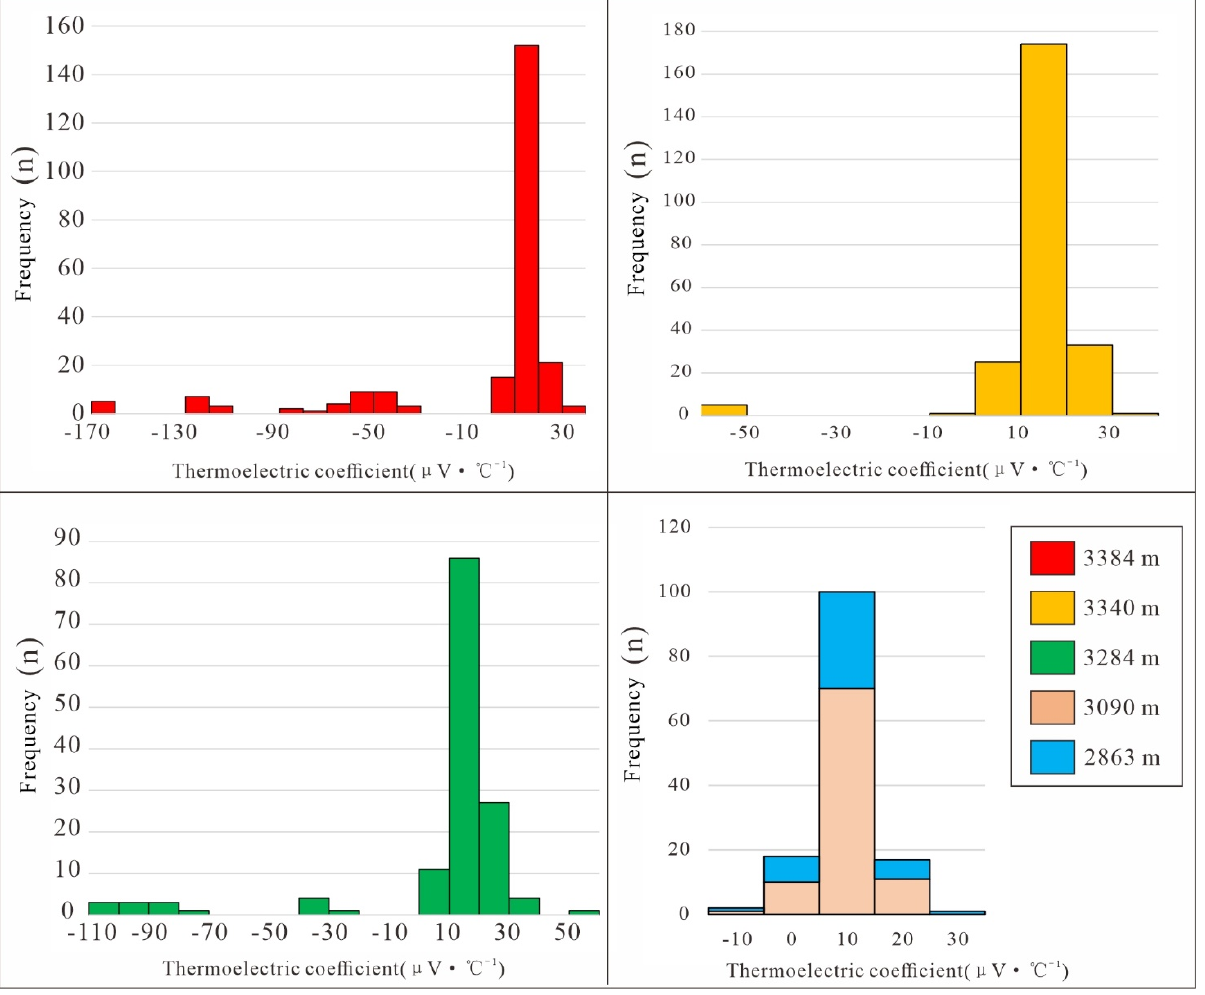
Figure 9. The histogram of thermoelectricity of pyrite.